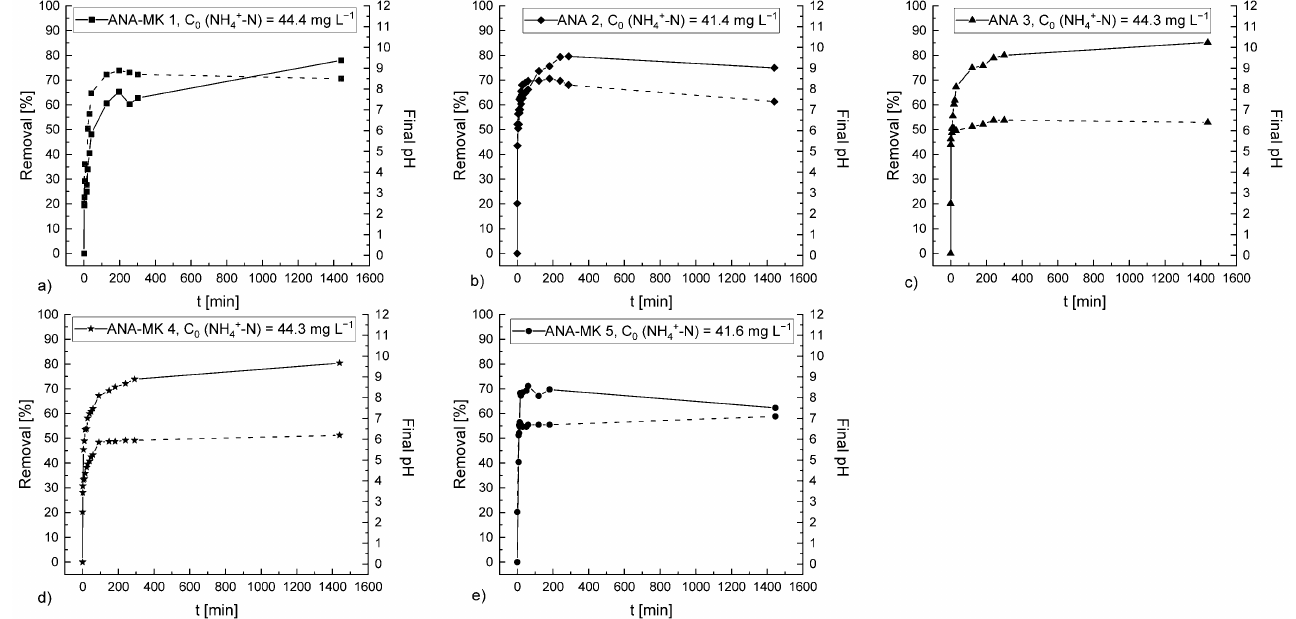
Figure 9. Effect of contact time on NH 4+ ion removal onto ( a ) ANA-MK 1, ( b ) ANA 2, ( c ) ANA 3, ( d ) ANA-MK 4, and ( e ) ANA-MK 5. The removal percentage of NH 4+ ions is represented by a solid line, and the final pH values are represented by a dashed line. Experimental conditions: sorbent dosage: 5 g L −1 ; the volume of the solution: 0.975 L; C 0 (NH 4+ -N): ~40 mg L −1 ; initial pH of the solution: 2.5; contact time: 24 h; and temperature: 22 °C – 23 °C.